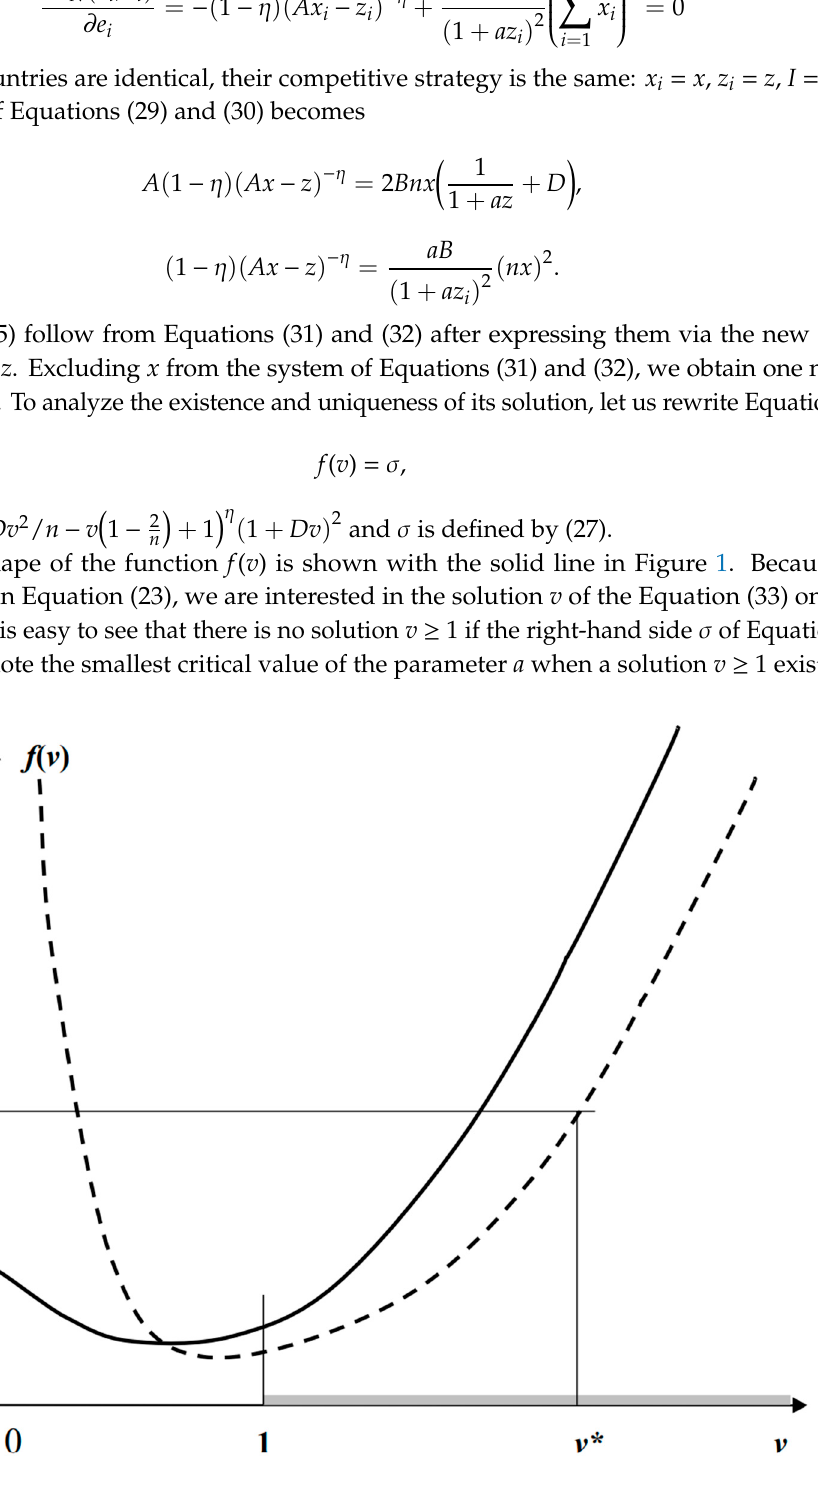
Figure 1. The function f ( v ) in the nonlinear Equations (26) (solid curve) and (47) (dashed curve). The acceptable interval (1, ∞ ) of the solution v * is indicated in bold